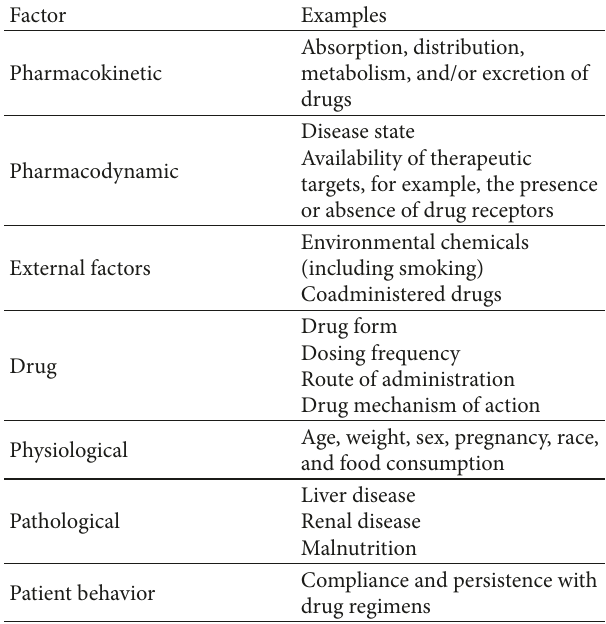
Table 1: Major factors affecting drug response in